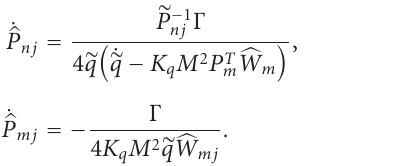
Figure 18: Input control with adaptive sliding observer-control.